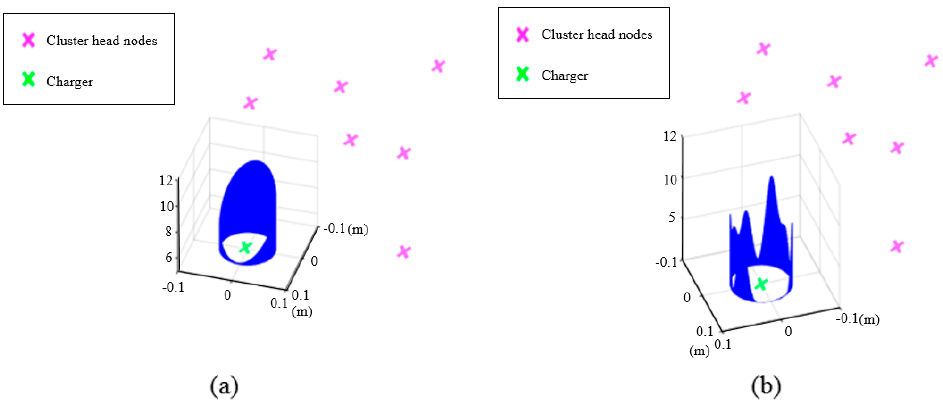
Figure 5. Variation in the power received by undercharged cluster heads according to angle θ : ( a ) P sc ( θ ) with an omnidirectional antenna; and ( b ) P A s ( θ ) with a directional antenna of 12 dB antenna gain.